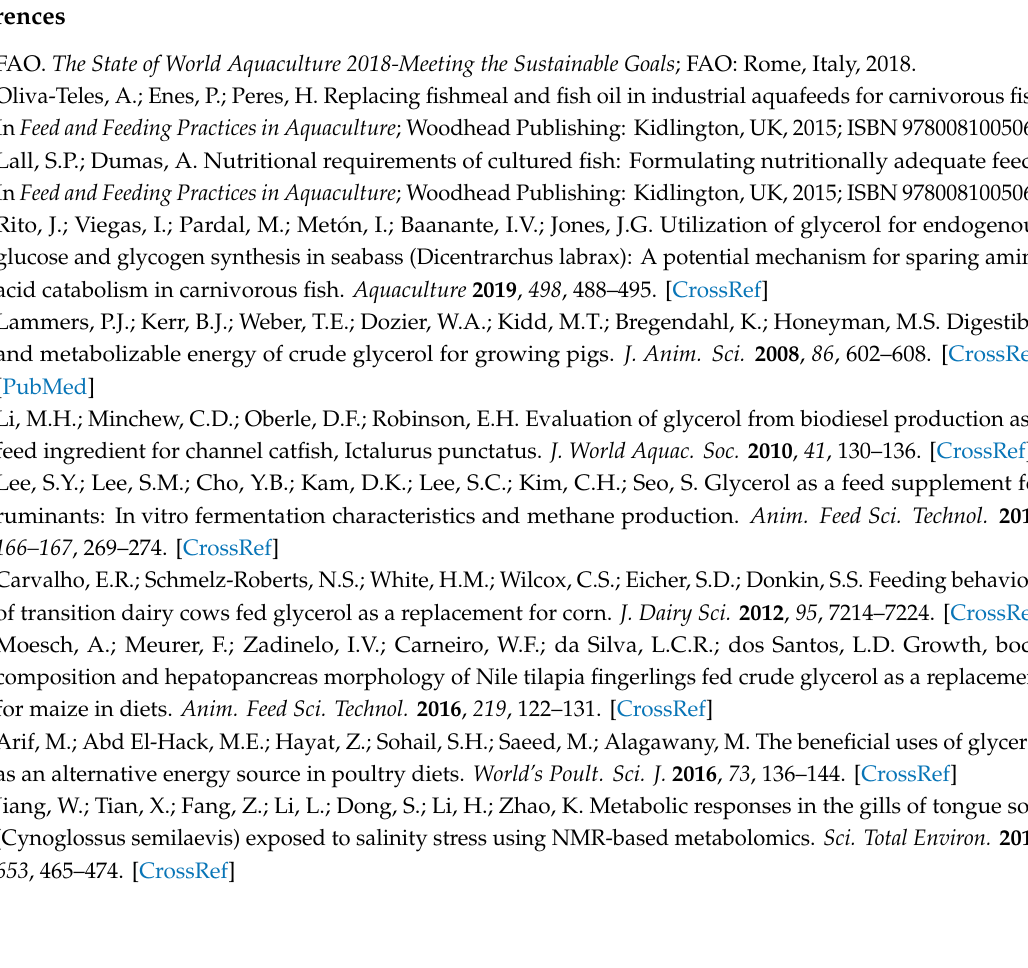
Figure S1: Partial least squares analysis (PLS) scores plot of muscle and liver of rainbow trout, Figure S2: Partial least squares analysis (PLS) scores plot of muscle and liver of European seabass, Table S1: Identified metabolites in muscle and liver of rainbow trout and European seabass with assigned peaks, Table S2: Fold-change of muscle metabolites of rainbow trout, Table S3: Fold-change of liver metabolites in rainbow trout, Table S4: Results of the comparison between groups in muscle of rainbow trout, Table S5: Results of the comparison between groups in liver of rainbow trout, Table S6: Fold-change of muscle metabolites of European seabass, Table S7: Fold-change of liver metabolites of European seabass, Table S8: Results of the comparison between groups in muscle of European seabass, Table S9: Results of the comparison between groups in liver of European